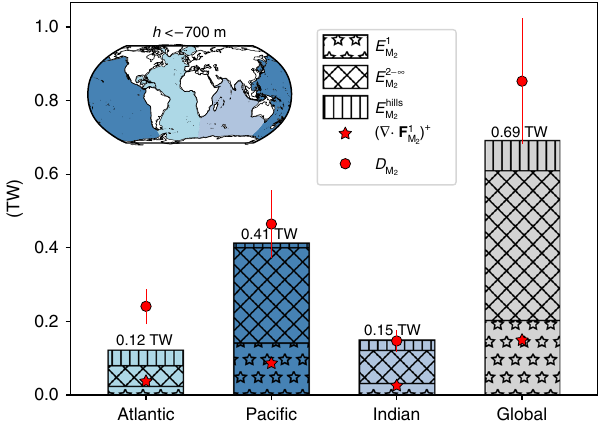
Fig. 1 Regional and global energy budgets for the M 2 tide. Stacked histograms represent energy conversion into mode 1 ( E 1 , starred areas), M 2 modes 2- ∞ ( E 2 (cid:1)1 , here excluding E hills , diagonally hatched areas) and the M 2 M 2 contribution from abyssal hills ( E hills , vertically hatched areas). Note that M 2 E 1 (cid:1)1 ¼ E 1 þ E 2 (cid:1)1 þ E hills . Red stars are the divergence of altimetry- M 2 M 2 M 2 M 2 Þ þ , and red bullets are the derived M 2 mode-1 energy fl ux, ð ∇ (cid:3) F 1 M 2 barotropic tide energy loss ( D ). Error bars show ±20% of D as M 2 M 2 suggested in Egbert and Ray 26 for deep-ocean integrals. The inset map shows the boundaries separating the different basins. Budgets are computed for sea fl oor depths greater than 700